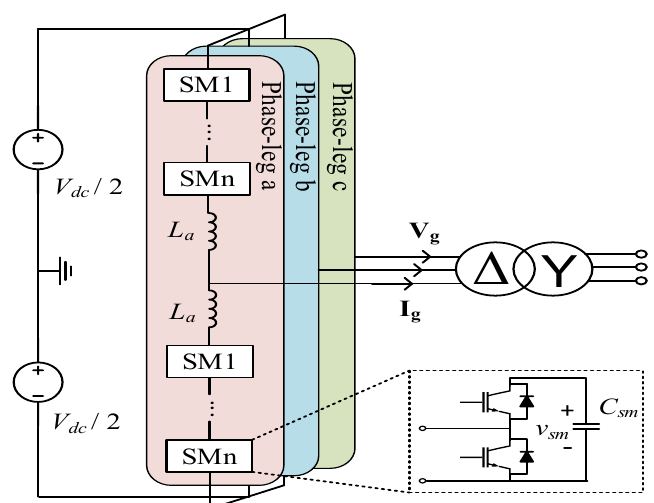
Figure 1. Schematic of a three-phase modular multilevel converter.